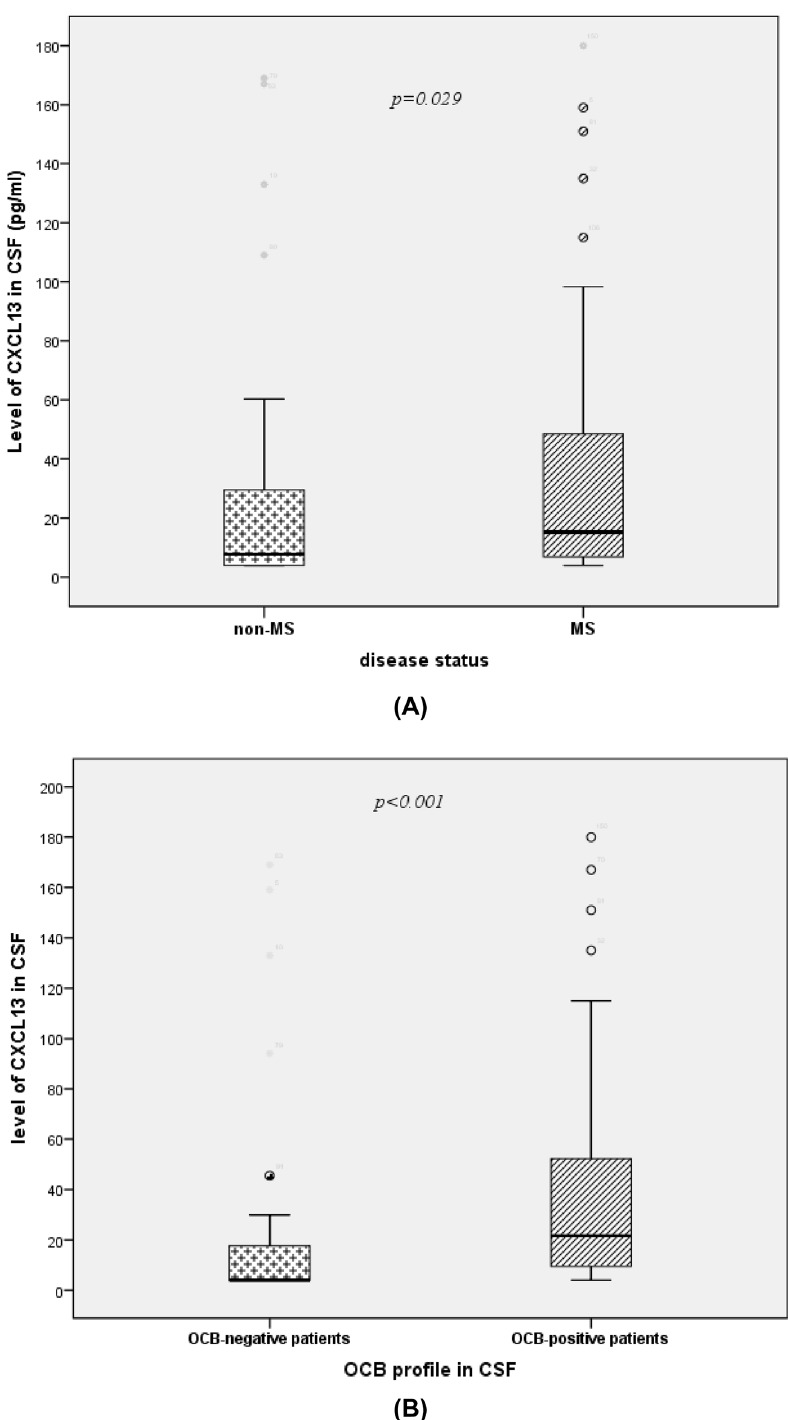
Figure 7. Comparative distribution of CXCL13 level in CSF: of multiple sclerosis (MS) vs non-MS patients ( A ); oligoclonal band (OCB)-positive vs OCB-negative patients ( B ) using U test of Mann–Whitney. Horizontal solid lines indicate